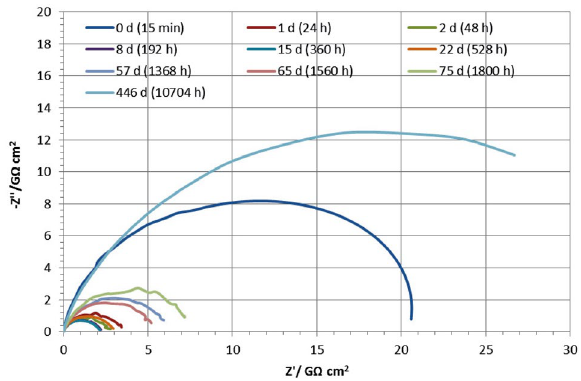
Figure 8. EIS spectra of the test panel as a function of immersion time (Nyquist plot – log I Z Re I vs. log IZ Im I ) during 466 d. The average value of capacitance equals 1.30 ± 0.13